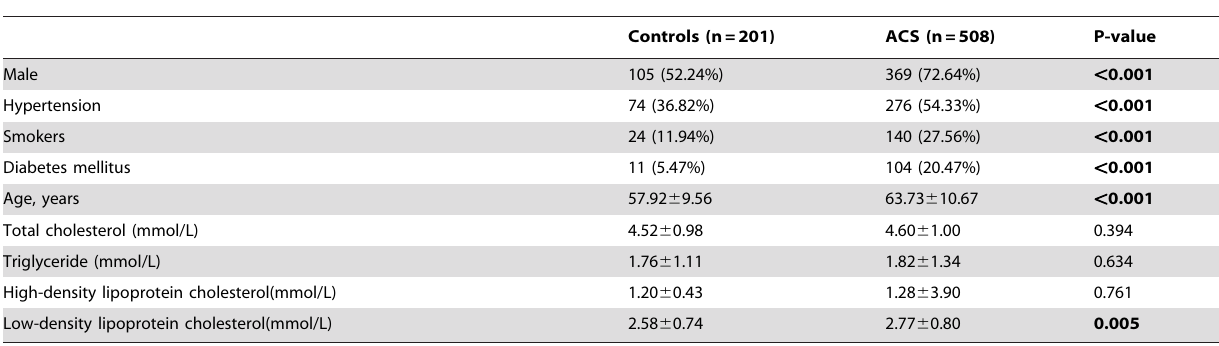
Table 1. Characteristics of the ACS and control